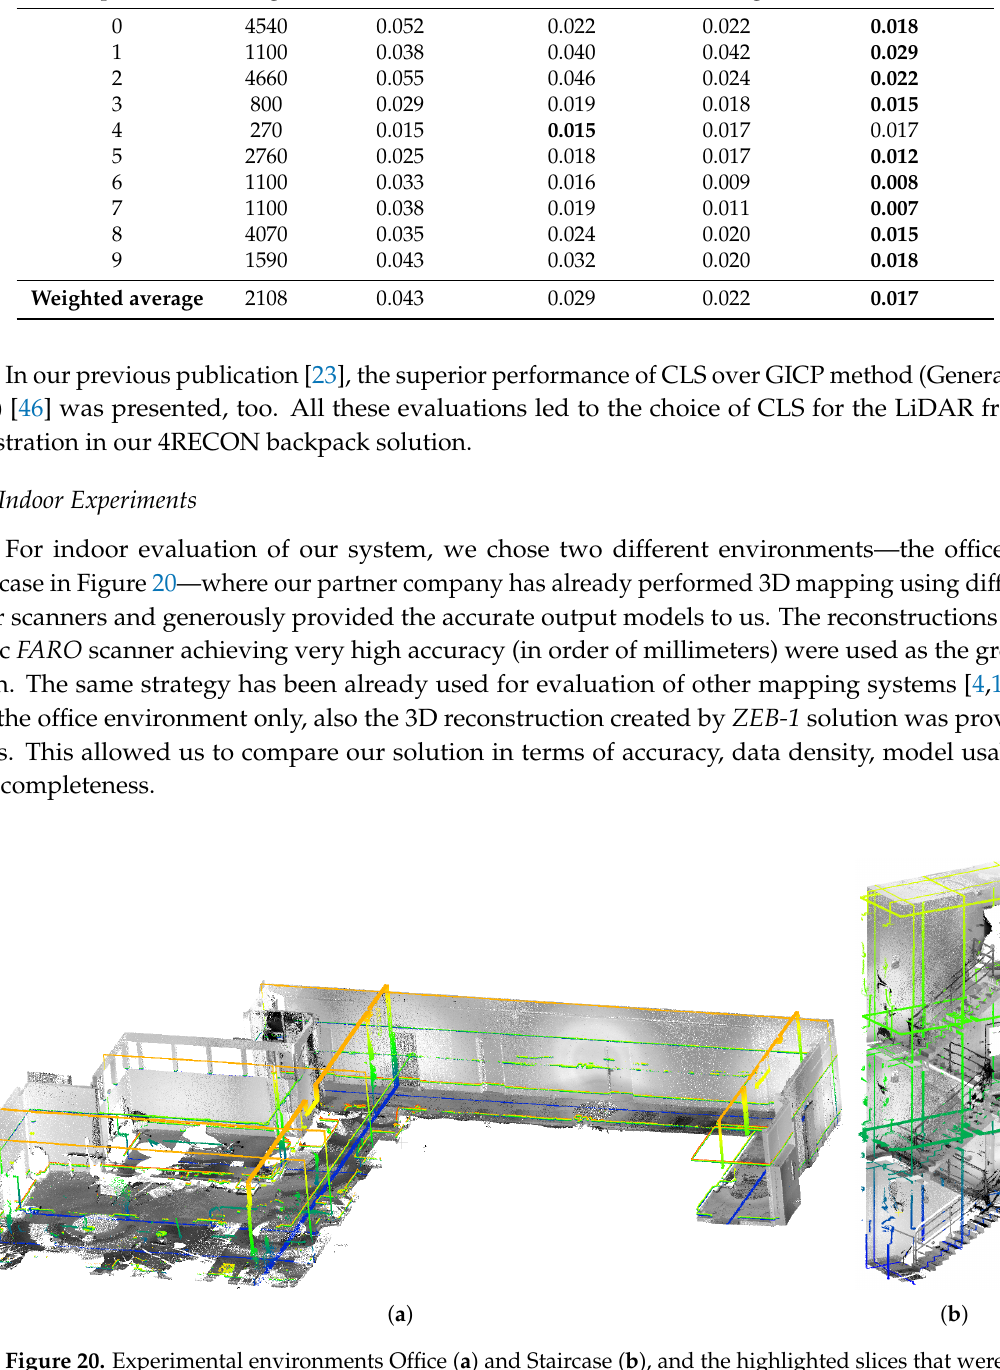
Figure 20. Experimental environments Office ( a ) and Staircase ( b ), and the highlighted slices that were used for precision